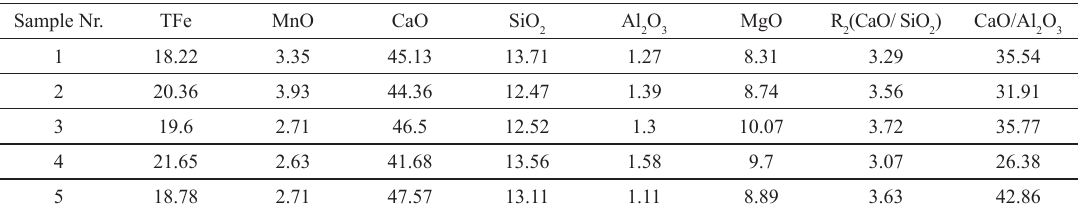
Table 1. The chemical compositions of slag samples before LF (mass%). Sample Nr.